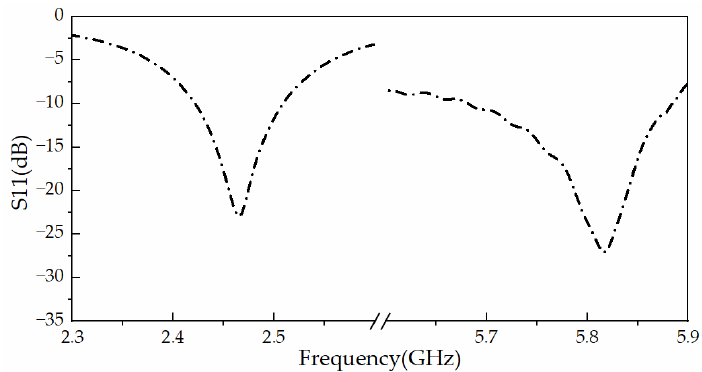
Figure 2. Simulated S11 of the proposed DRA.